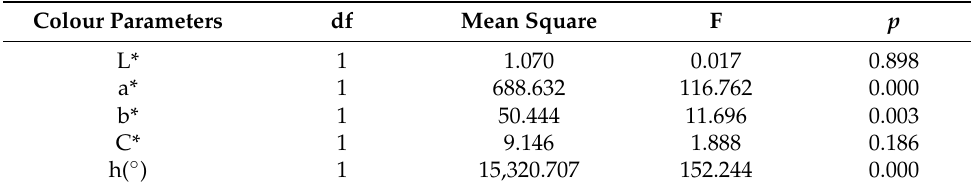
Table 2. ANOVA results for the colour parameters.